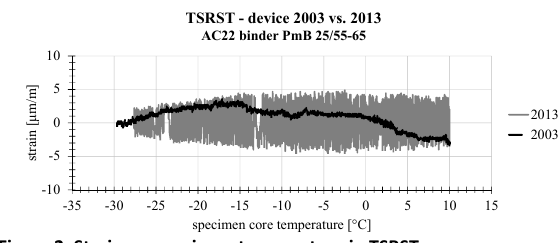
Figure 2. Strain vs. specimen temperature in